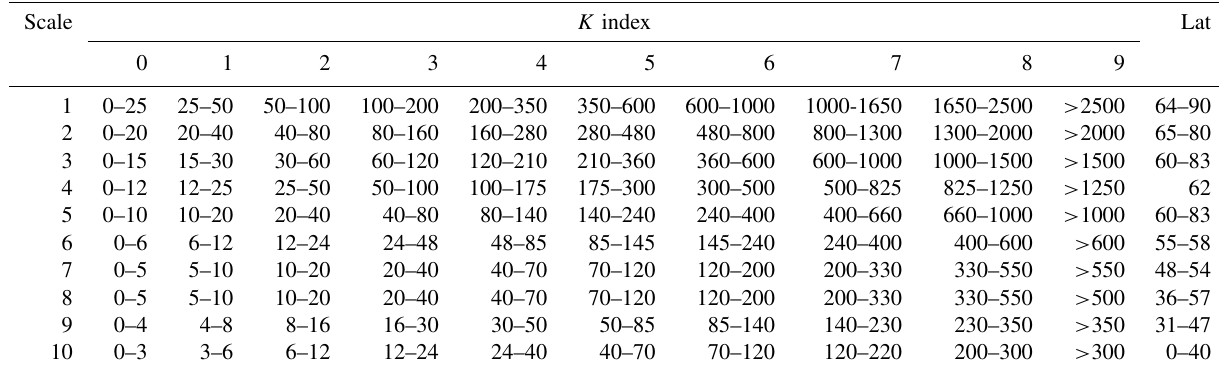
Table 2. Correspondence of geomagnetic disturbance amplitudes (in nT) to K index values depending on the geomagnetic latitude of the